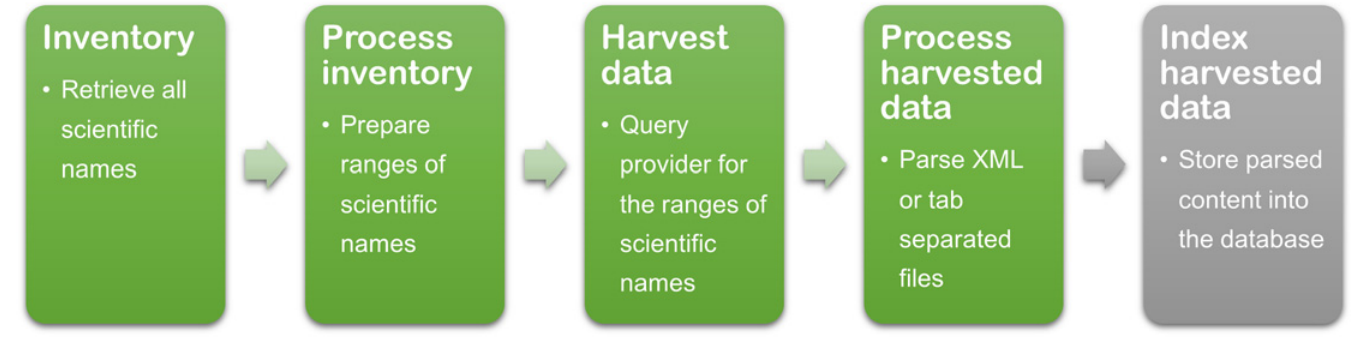
Fig 1. GBIF-HIT Harvesting process. It consists of 4 major steps that have to be executed after each update of a datasource. The harvested data is eventually parsed and stored into the